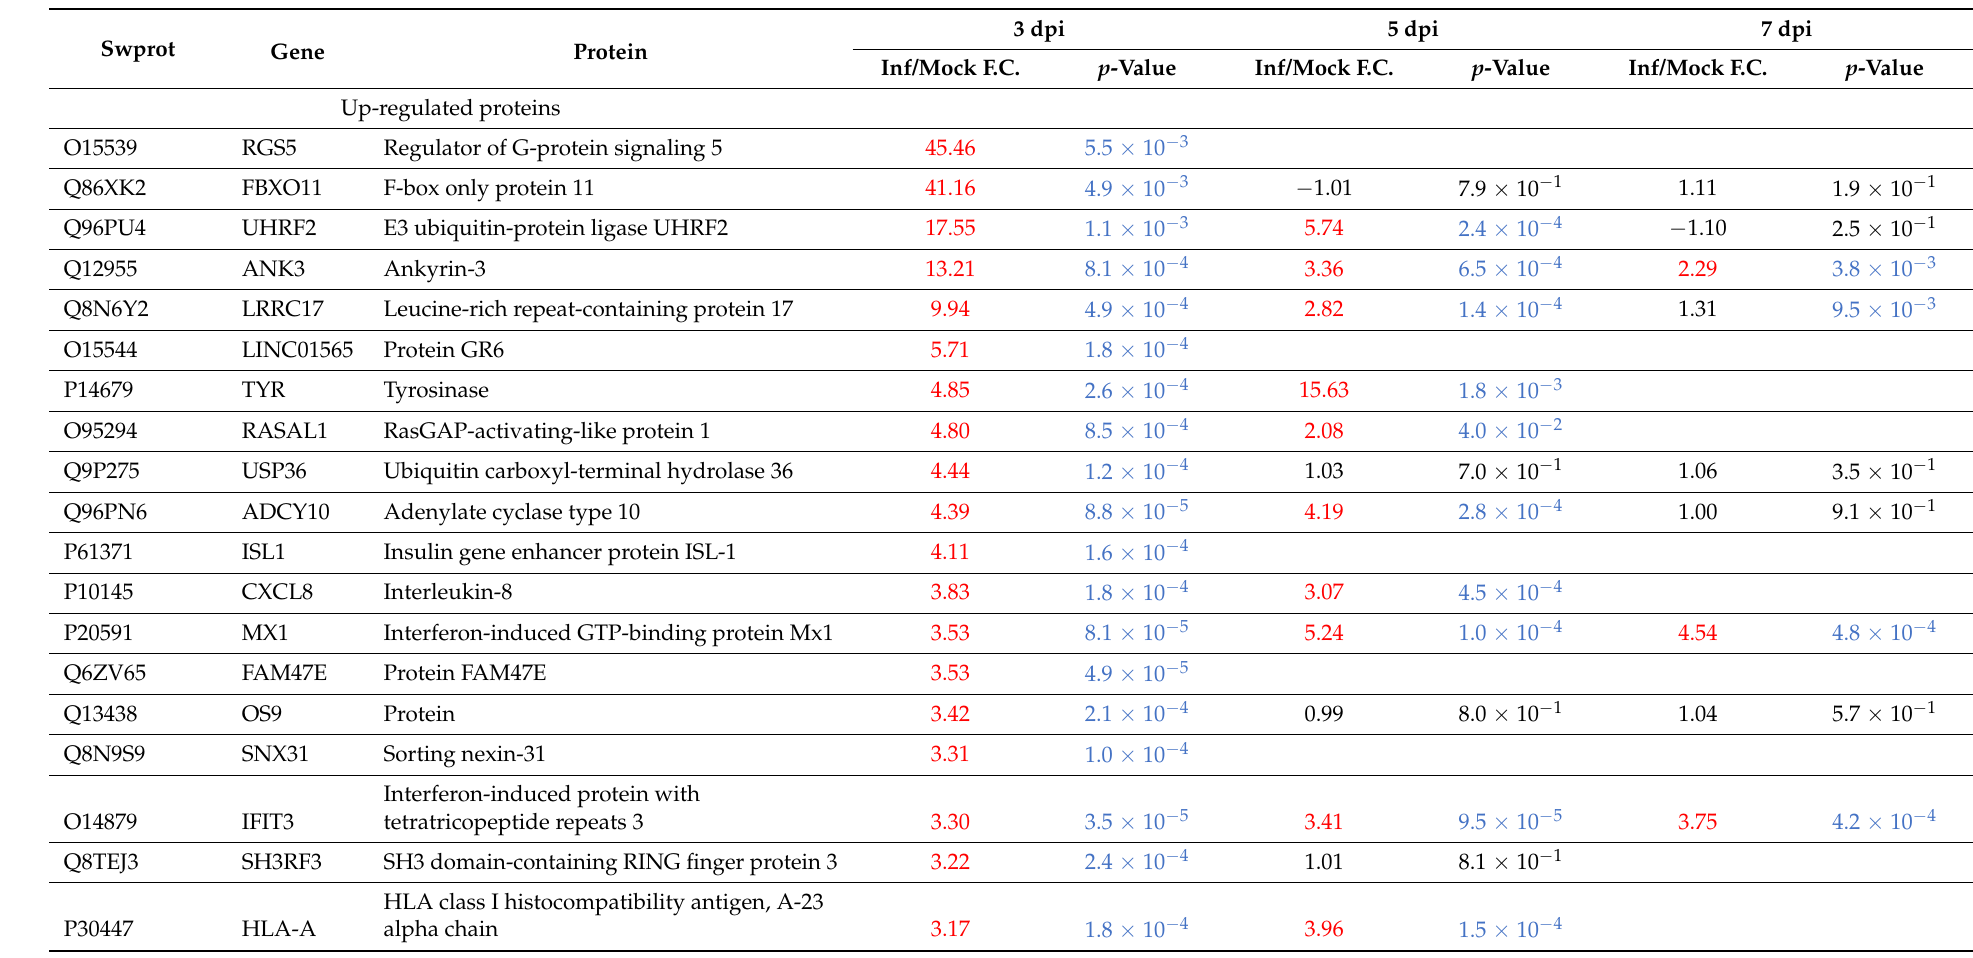
Table 2. List of protein levels altered at least 2-fold and significant by t -test ( p -value < 0.05) or Z-score ( ≥ 1.96 σ or ≤− 1.96 σ ). Swprot Gene